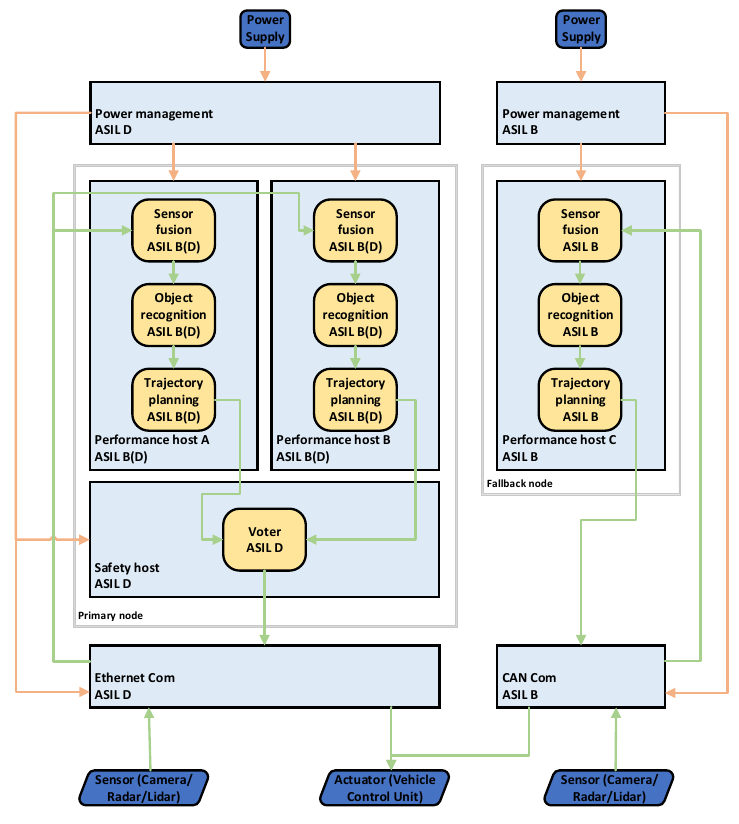
Figure 4. Hybrid